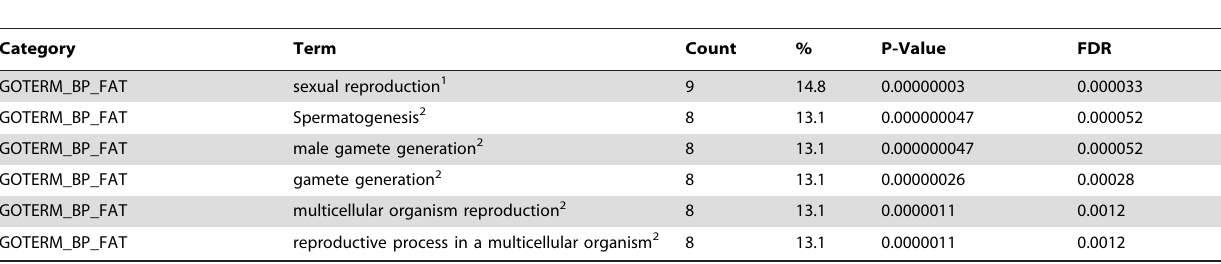
Table 4. Top 6 GO terms from the functional annotation analysis of 97 CSFR genes by